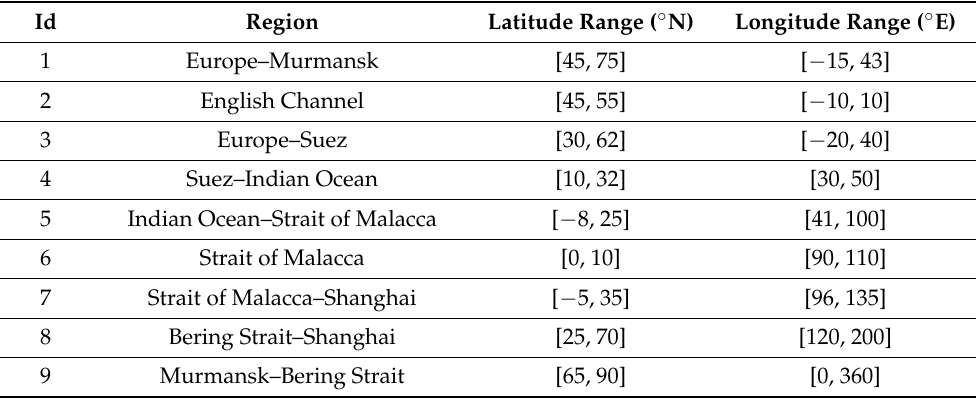
Table 1. Primary regions of focus for environmental